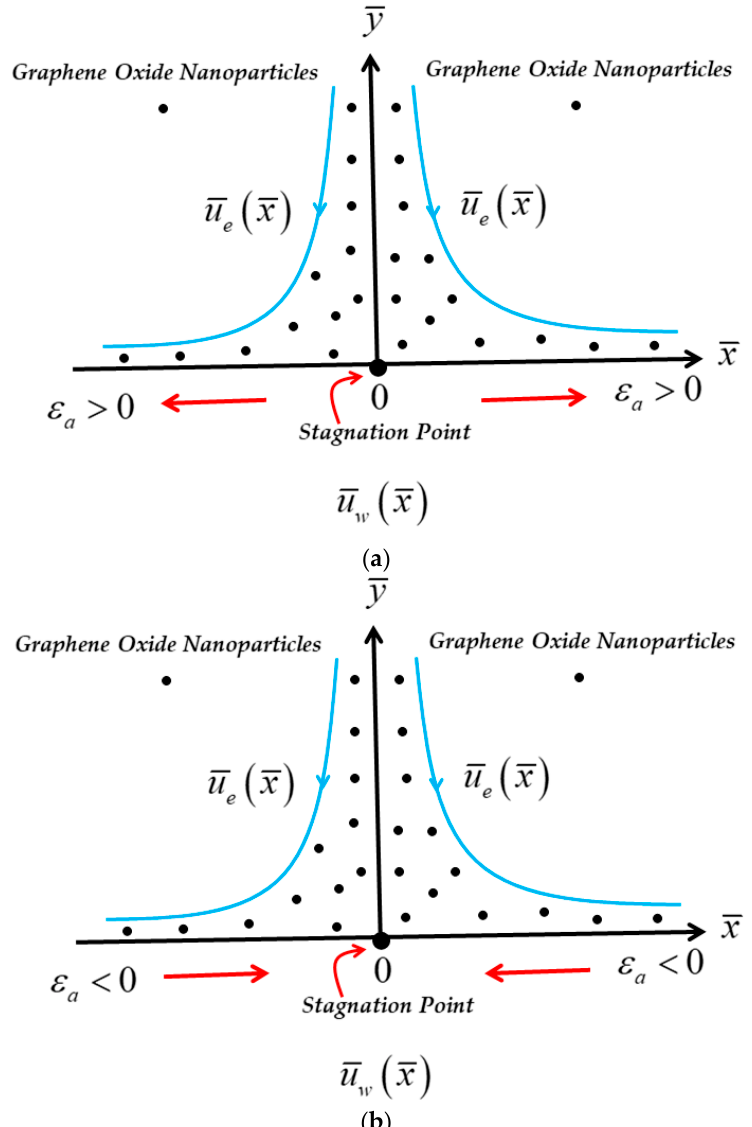
Figure 1. Physical model and coordinate system. ( a ) Stretching Sheet; ( b ) Shrinking Sheet.